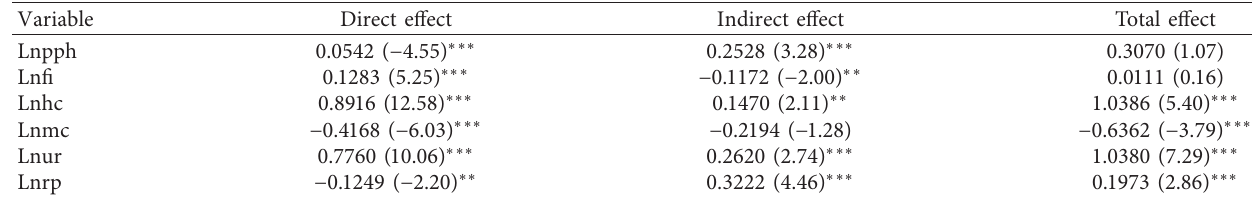
Table 7: Direct, indirect, and total effects of SDM with time fixed